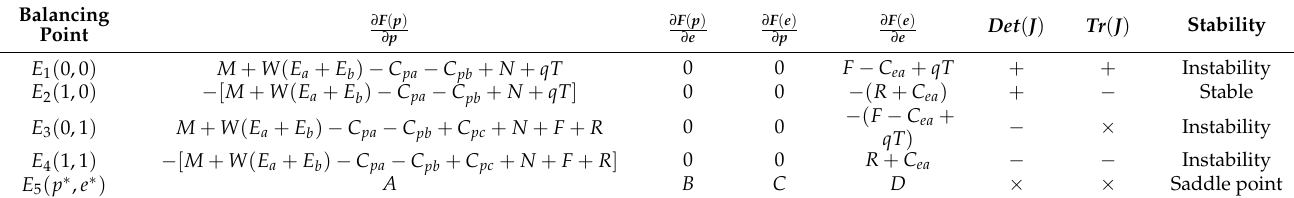
Table 5. Stability analysis of the strategy combination in the shared manufacturing supply chain rationality, shared platform rationality